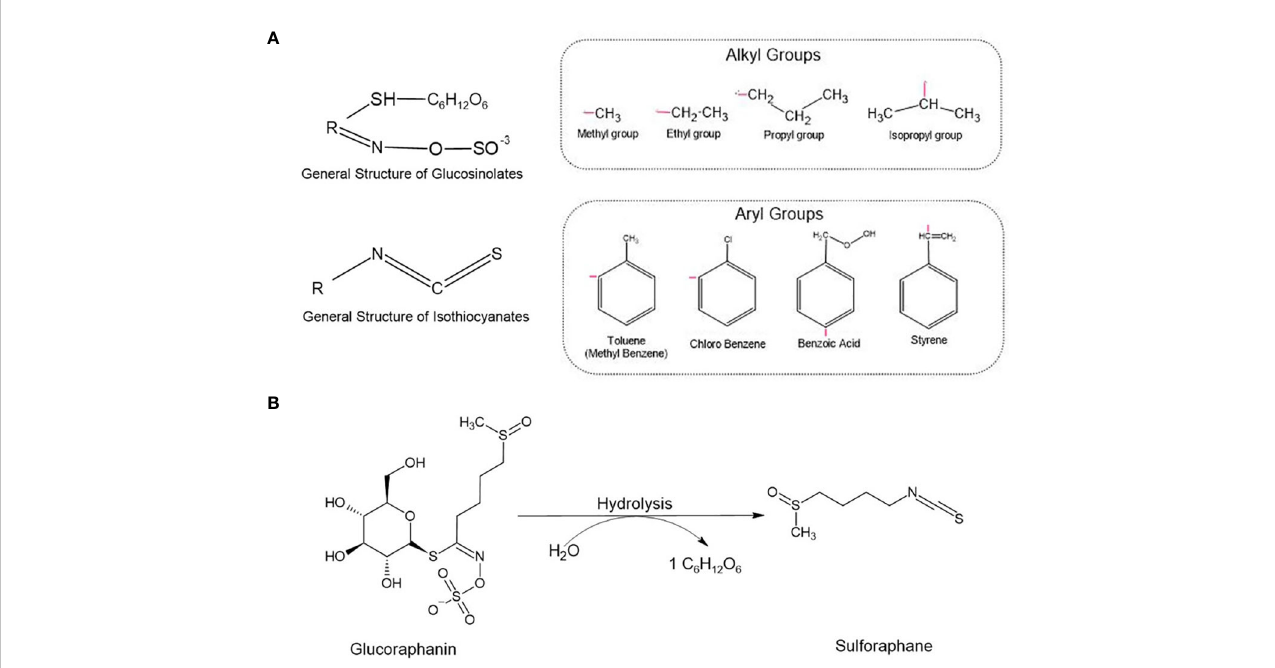
FIGURE 1 (A) Glucosinolates and Isothiocyanates general structures. The radical ‘ R ’ represents different alkyl and aryl groups. (B) Glucoraphanin, a glucosinolate, is converted into sulforaphane (SFN) by the enzyme myrosinase. During the chemical reaction, glucoraphanin is hydrolyzed releasing a glucose molecule (C 6 H 12 O 6 ) and resulting in the active form of